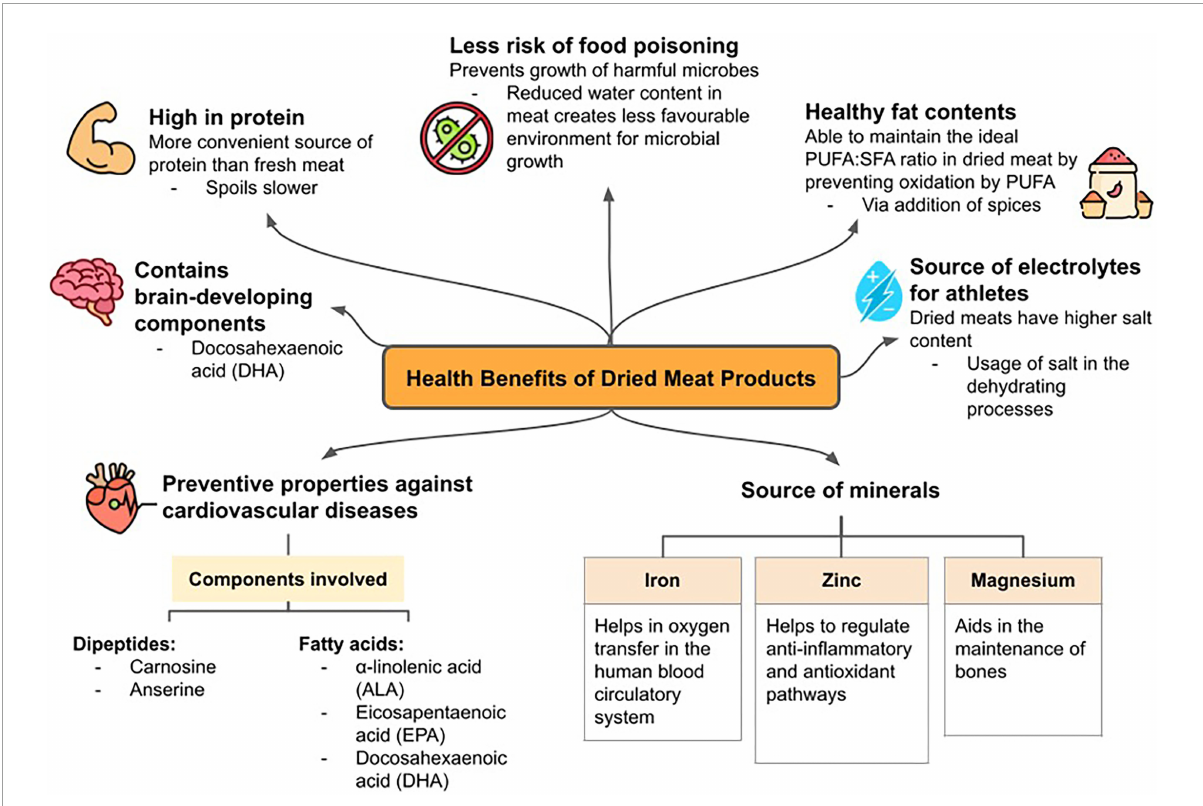
FIGURE1 Health benefits of dried